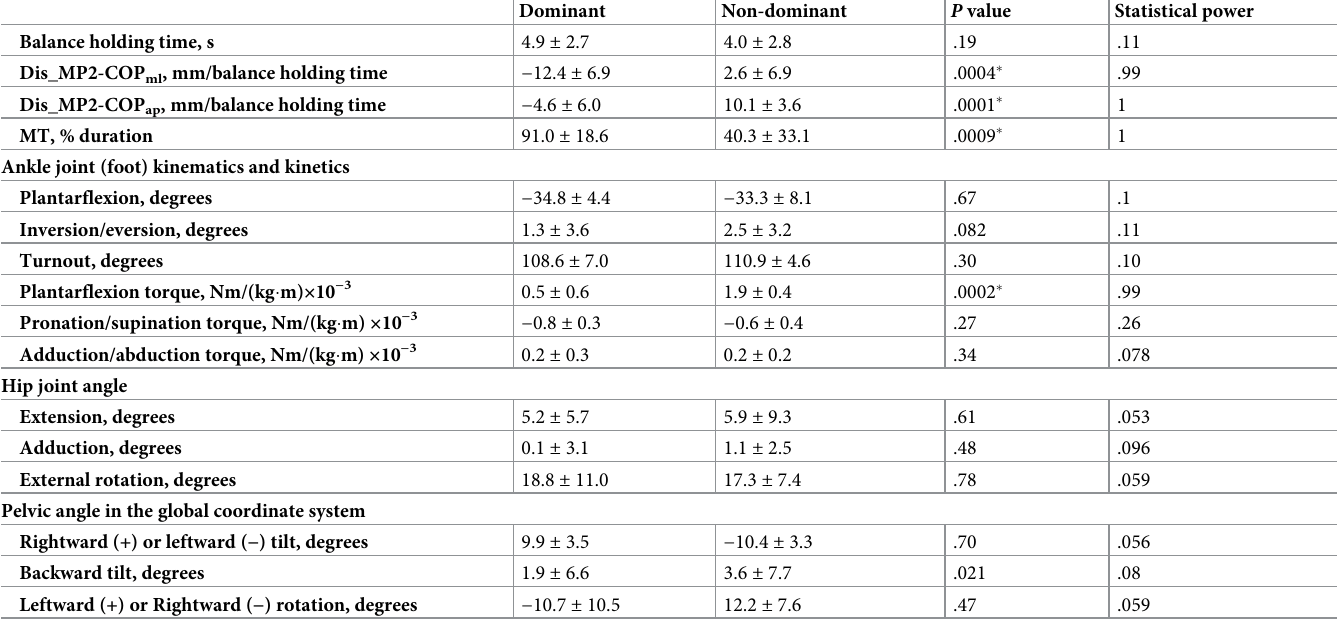
Table 4. Comparison of kinematics and kinetics between both legs during tiptoe